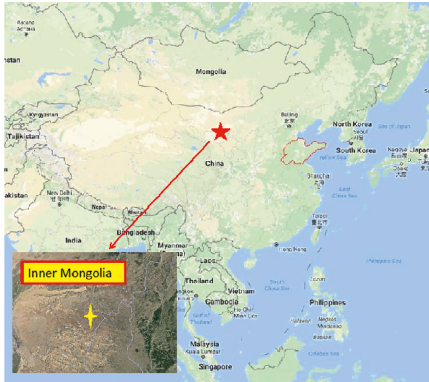
Figure 2: Location of the Mentai Buliangou Coal Mine, Inner Mongolia,